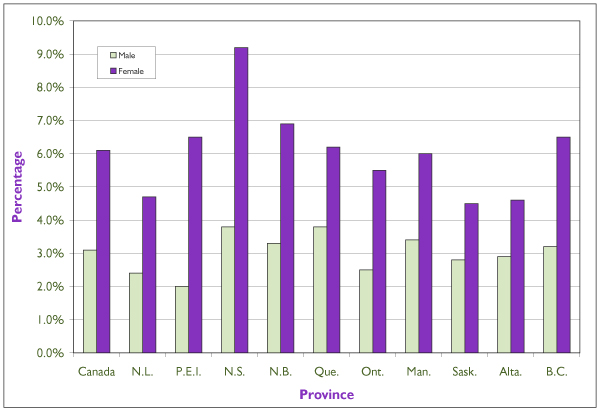
Prevalence of depression by sex and province, 1998–1999 Source: National Population Health Survey, 1998–1999